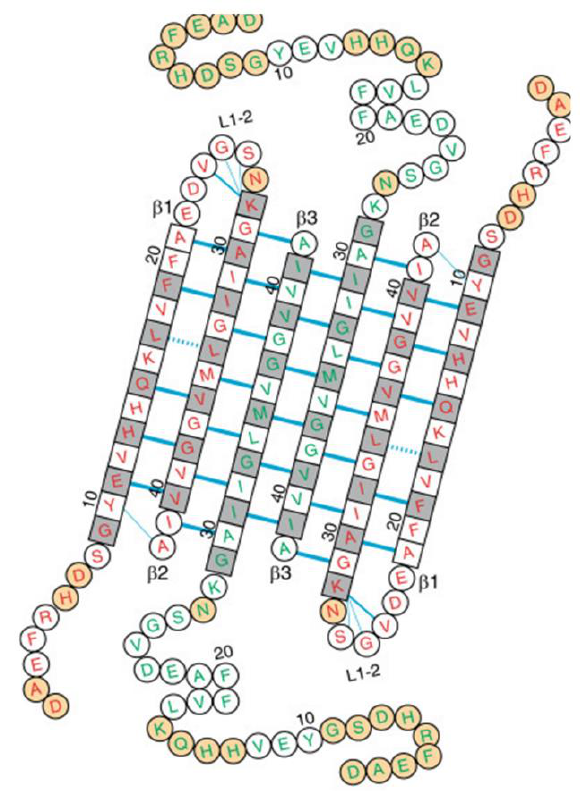
Figure 5. The amino acid sequence of the Aβ(1–42) tetramer arranged on the basis of the secondary and tertiary structure in the detergent DPC [37]. Amino acids in squares denote β-sheet secondary structure as identified by secondary chemical shifts; all other amino acids are in circles. Blue lines denote experimentally observed NOE contacts between two amide protons. The side chains of white and gray residues point towards distinct sides of the β-sheet plane. Orange circles correspond to residues that could not be assigned.